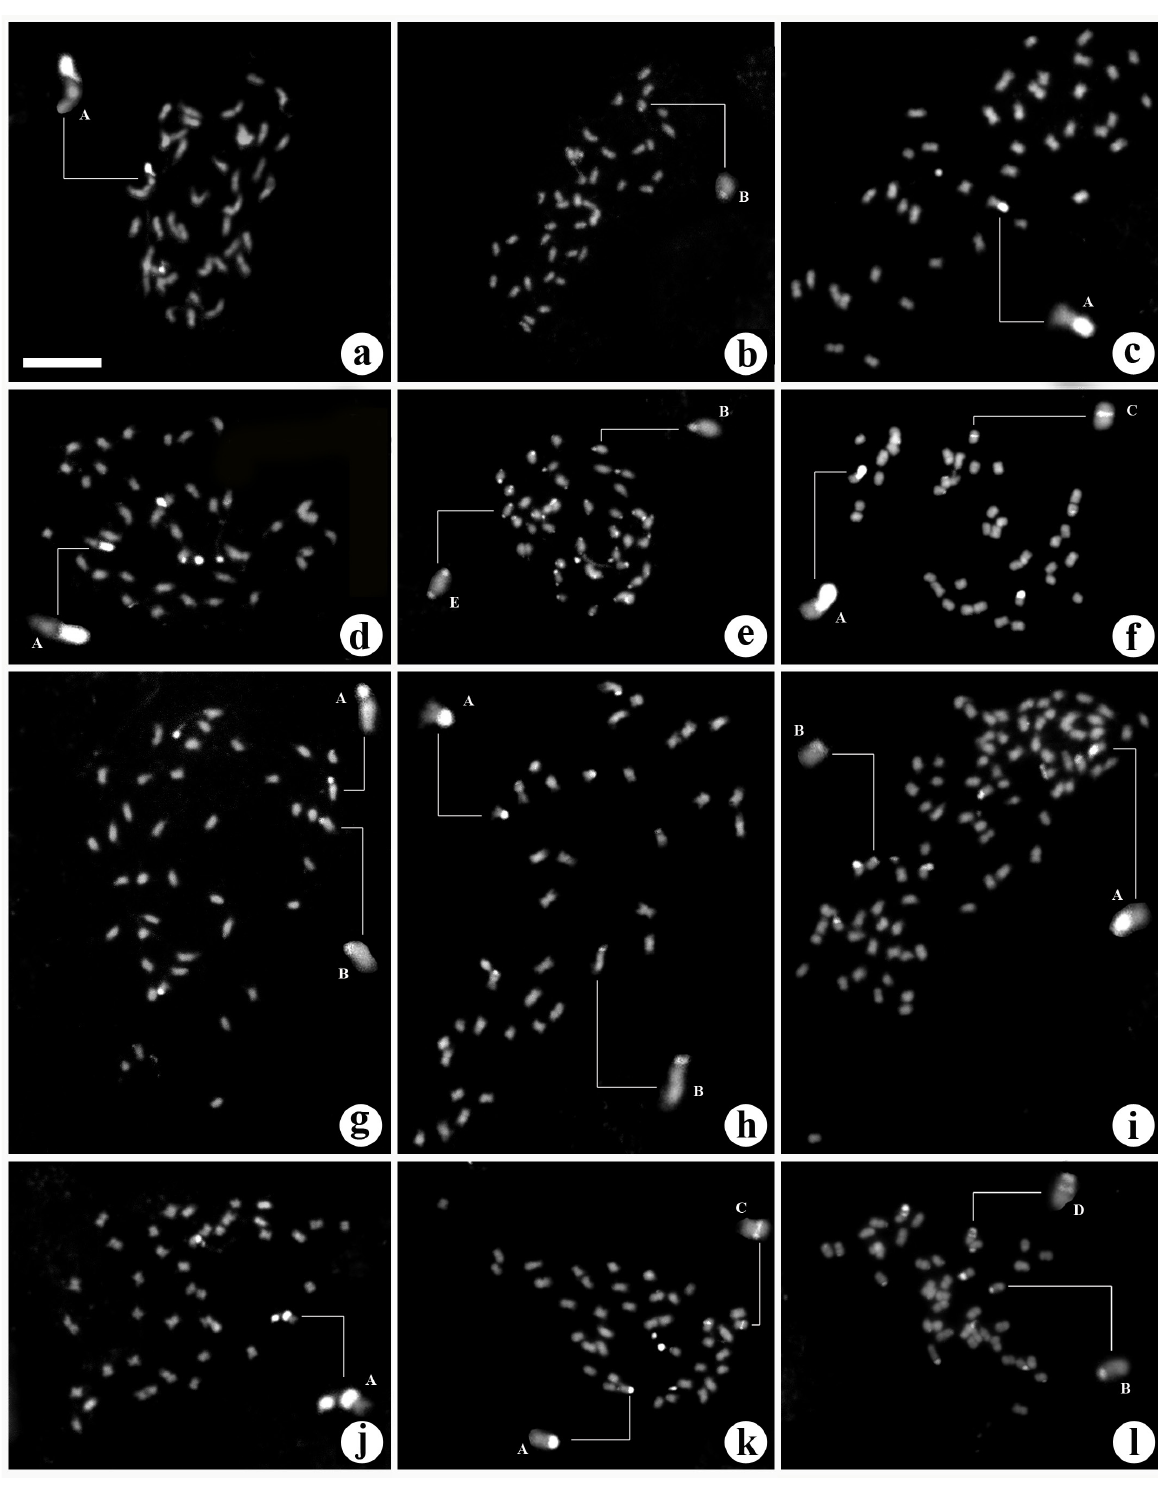
Figure 2 - Distribution of CMA + bands in Bignonieae (Bignoniaceae) species: a. Fridericia dichotoma , b. F . erubescens , c. F. limae , d. F . platyphylla , e. F . pubescens , f. F. subverticillata , g. Lundia longa , h. Mansoa difficilis , i. Pyrostegia venusta , j. Stizophyllum riparium , k. Tanaecium selloi , l. Xylophragma myrianthum . Scale bar in a corresponds to 10